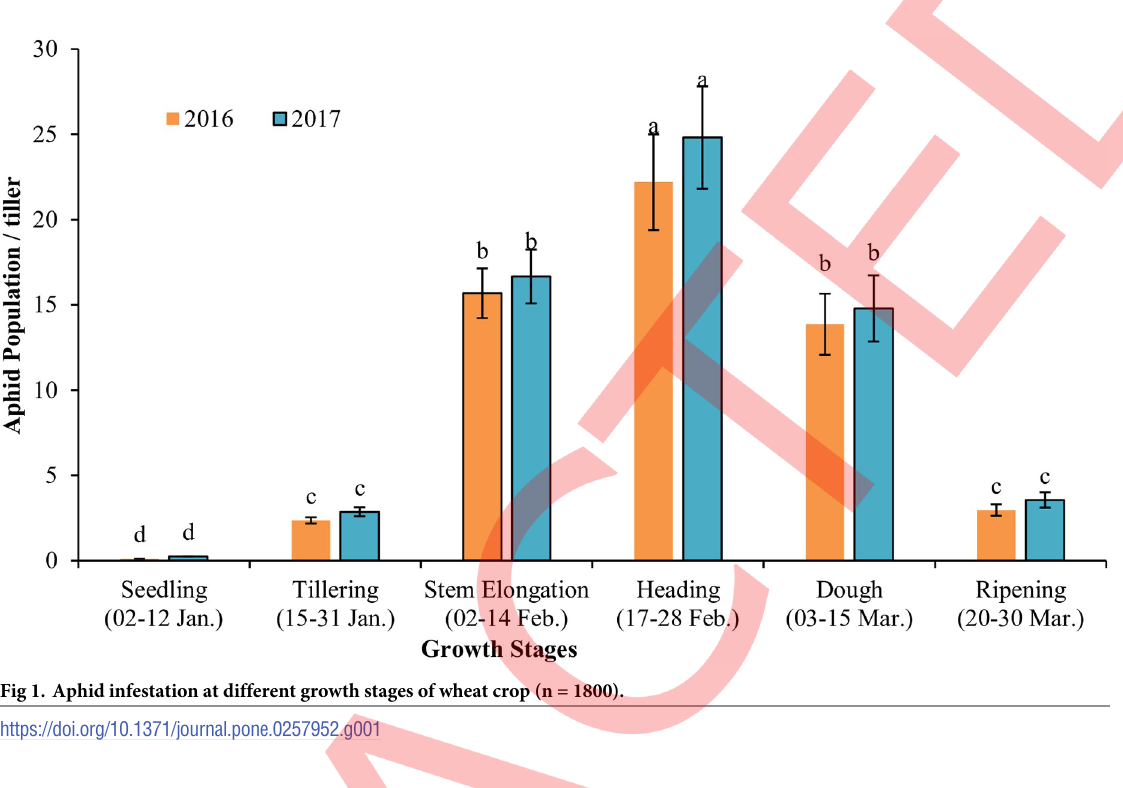
Fig 1. Aphid infestation at different growth stages of wheat crop (n = 1800).